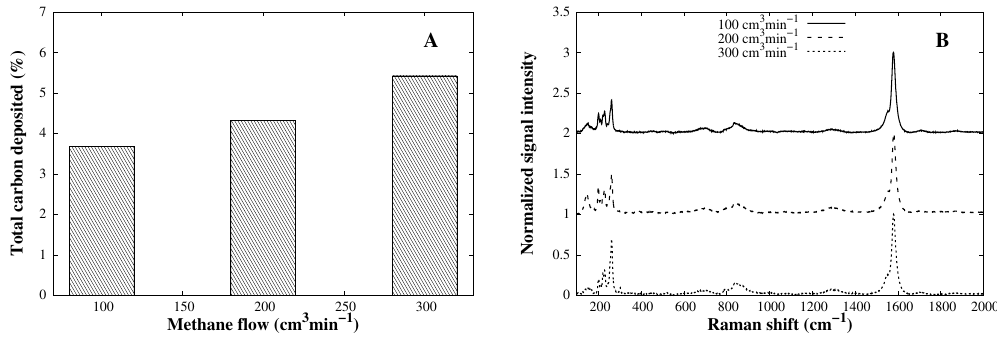
Figure 6. ( A ) Total carbon content dependency on methane flow rate and ( B ) complete Raman spectra of CVD products.